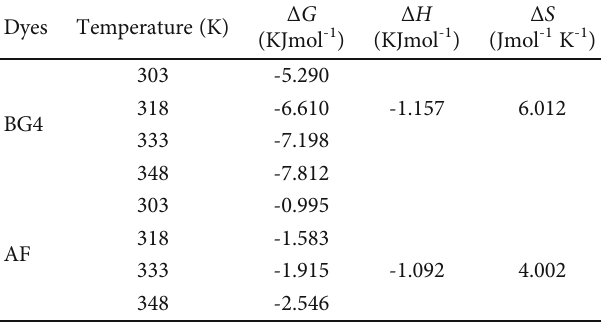
Table 5: Thermodynamic parameters.